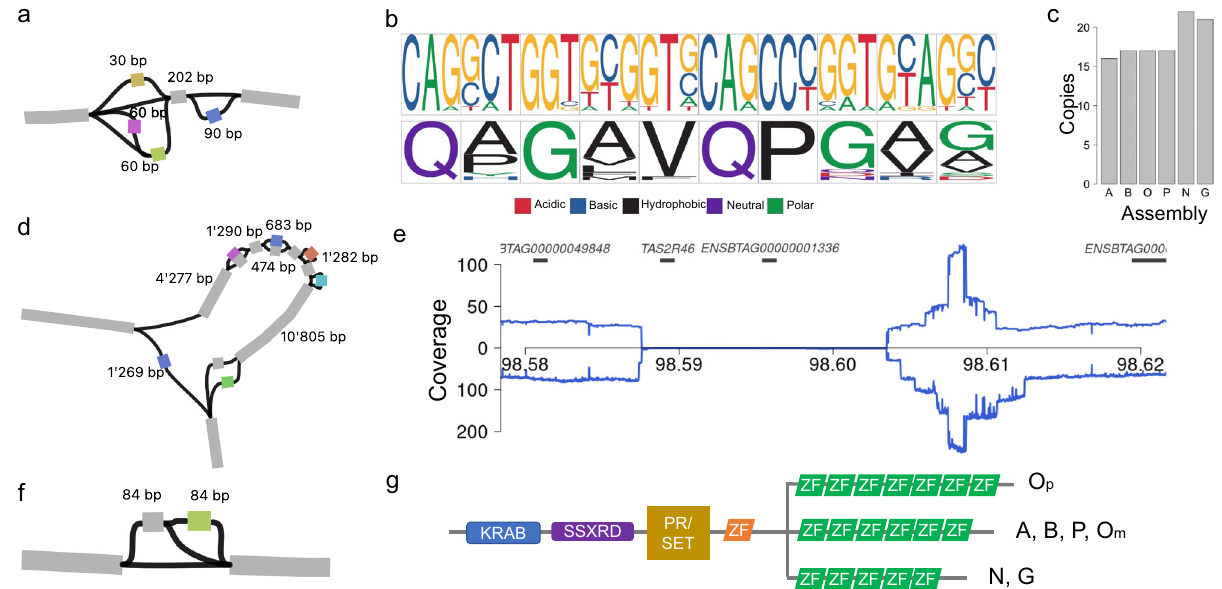
Fig. 7 Identi fi cation of structural variation in coding sequences of QRICH2 , TAS2R46 and PRDM9 through the HiFi-based pangenome. a Pangenome topology in the fi fth exon of bovine QRICH2 revealed tandem repeats of 30 bp sequence. b Nucleotide (upper) and protein (lower) sequence logo plot of the repeat motif. c While the ARS-UCD1.2 reference sequence contains 15 copies of the repeat motif, the pangenome revealed 1, 5, and 6 additional copies in the fi ve haplotype-resolved assemblies (A — ARS-UCD1.2, B — Brown Swiss, O — Original Braunvieh, P — Piedmontese, N — Nellore, G — gaur). d Representation of a 17 kb deletion on BTA5 encompassing TAS2R46 and ENSBTAG00000001761. e Coverage of binned HiFi (above horizontal line) and ONT (below horizontal line) long read alignments in gaur indicate a large deletion between 98,587,384 and 98,604,401bp. f Pangenome topology at the eleventh exon of PRDM9 indicating paths with gain and loss of 84 bp sequence. g Representation of the domains of PRDM9 in the haplotype-resolved assemblies including a variable number of zinc fi ngers (ZF) in the different assemblies, where O m and O p are the maternal and paternal haplotypes of the